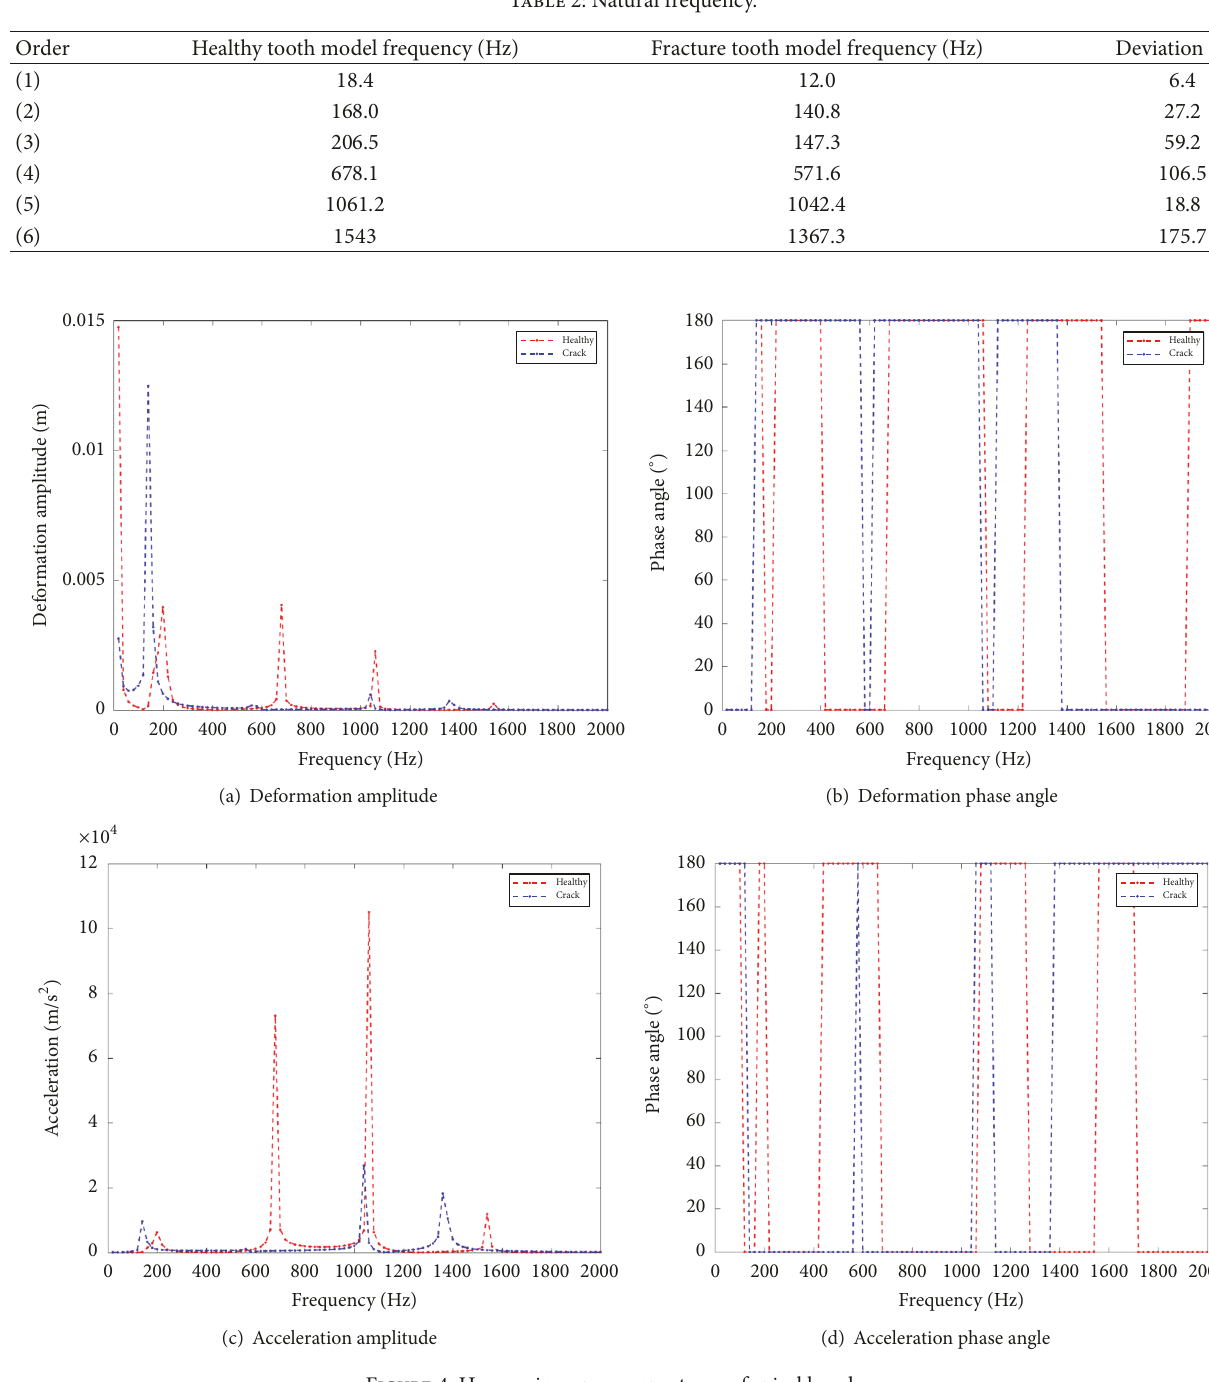
Figure 4: Harmonic response spectrum of spiral bevel